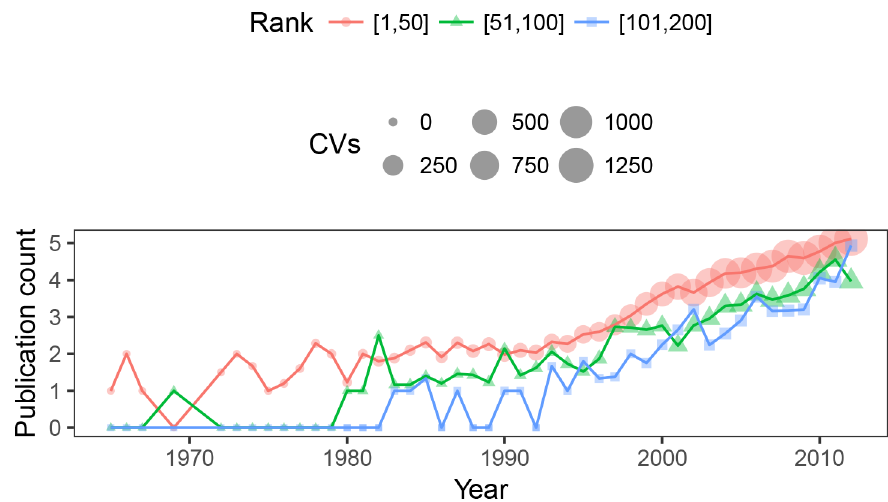
Figure 3 - Average publication rate per-researcher according to the prestige rank of their institutions. This figure counts publications in CVs of researchers with PhD in Computer Science which declared affiliation to a top-200 institution. This rate increases around 1995 due to the growth of the number of PhDs.